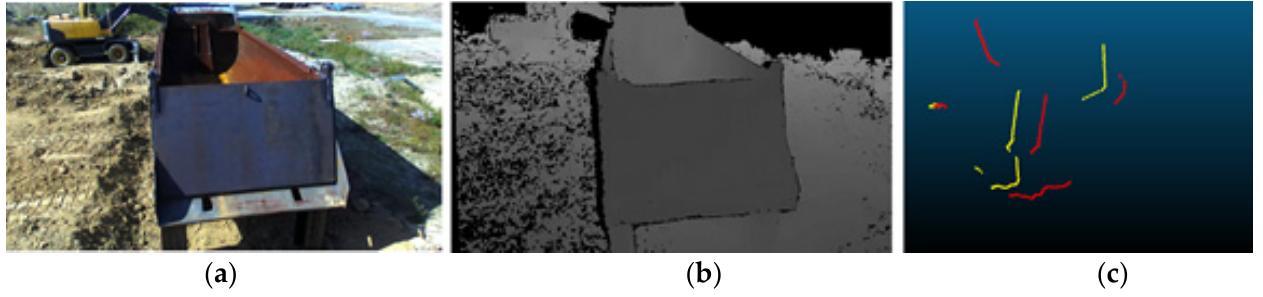
Figure 18. Three-dimensional location estimation experiment for the cargo box of dump truck: ( a ) an experimental model built for experimentation; ( b ) an experiment example using an excavator. The sensor is placed on the top of the excavator.